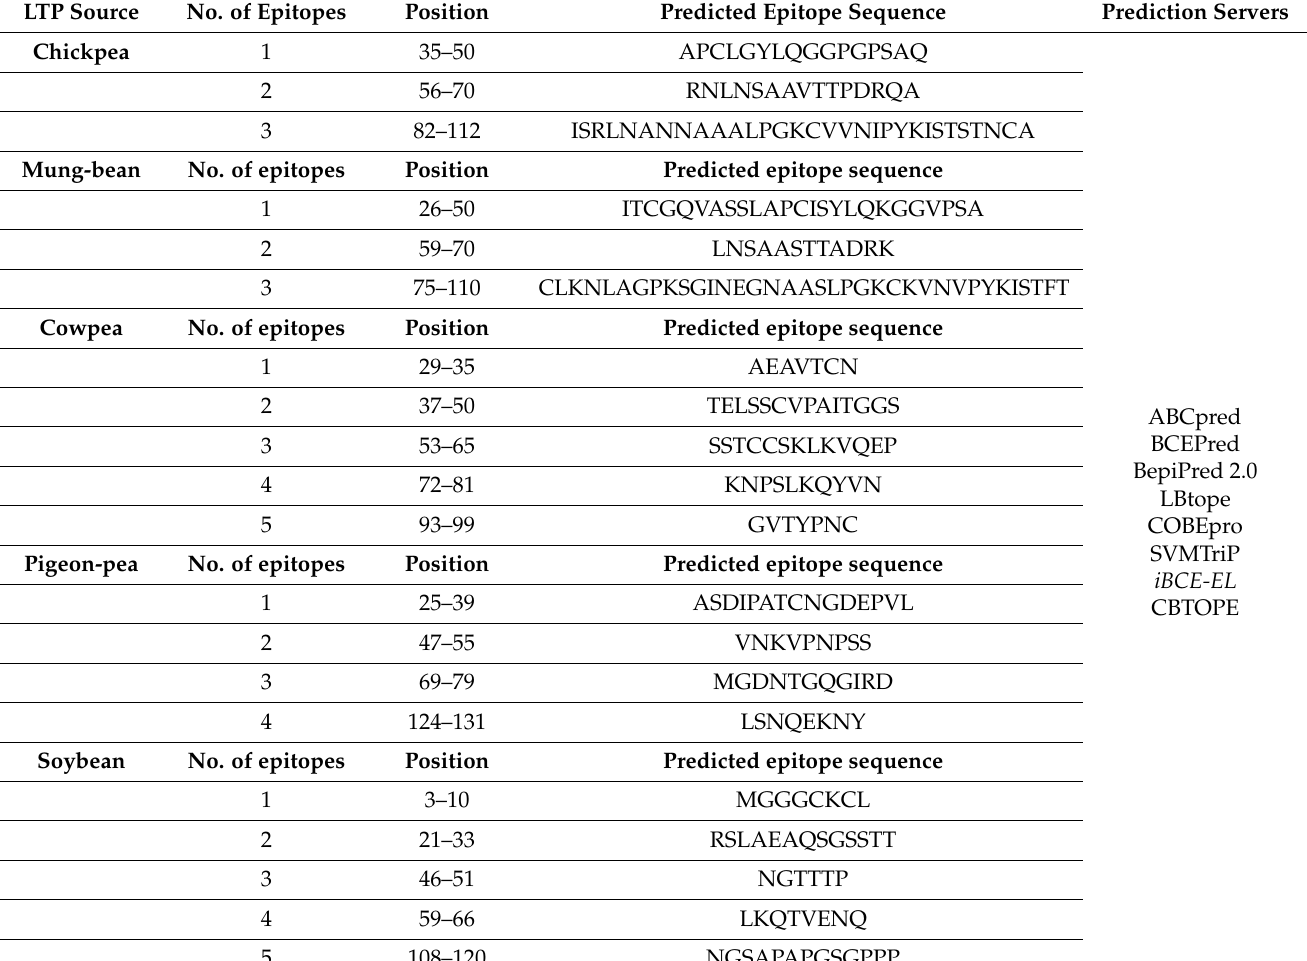
Table 2. Consensus of linear and conformational IgE binding epitopes of chickpea, mung-bean, cowpea, pigeon-pea, and soybean LTPs, respectively, using eight